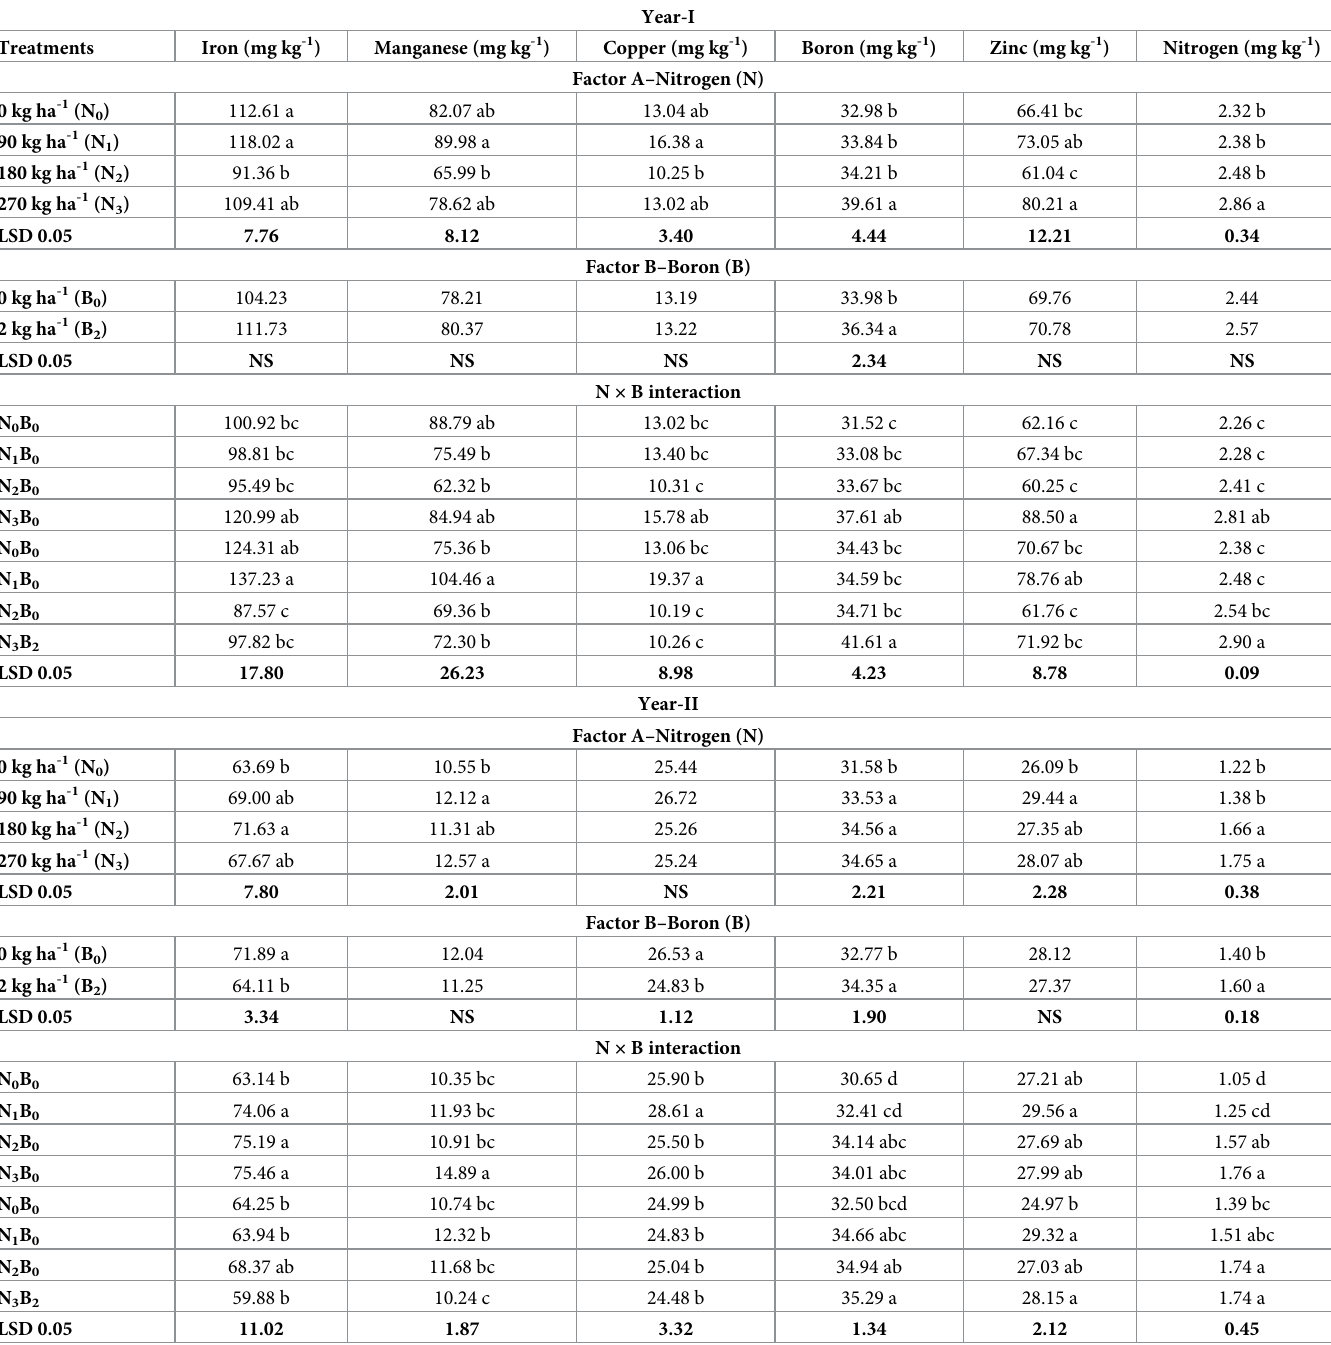
Table 5. The impact of different nitrogen and boron doses and their interaction on micro mineral contents in watermelon rind.